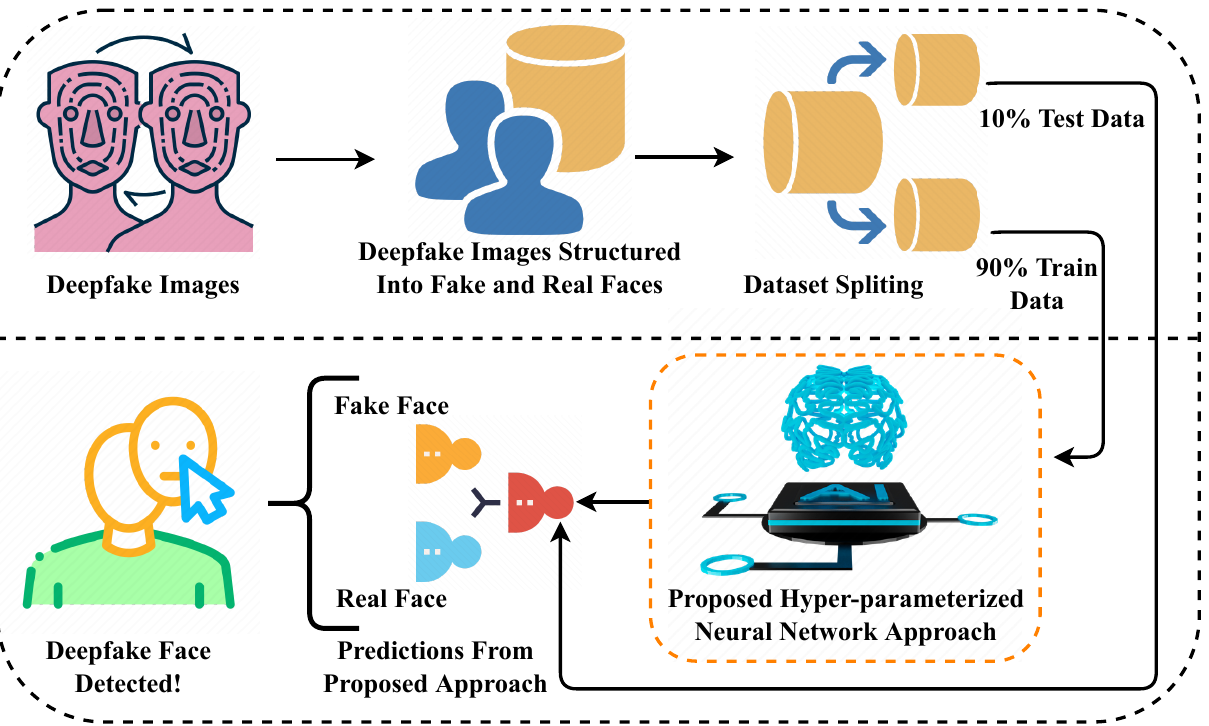
Figure 1. The methodological architectural analysis of our novel proposed research study in deep- fake